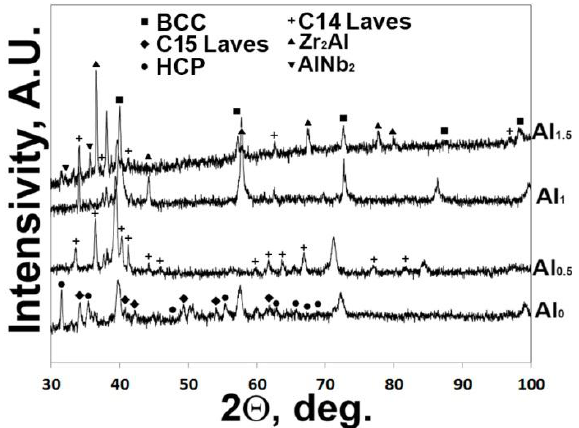
Figure 5. XRD patterns of the Al x NbTiVZr ( x = 0; 0.5; 1; and 1.5) alloys after annealing at 800 °С for 100 h. Metals 2016 , 6 , 298